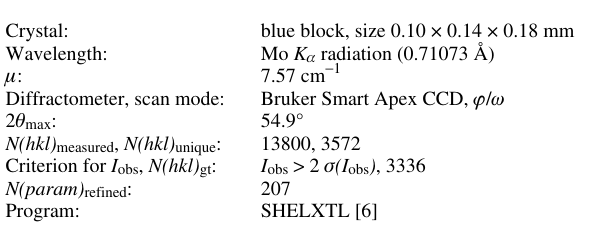
Table 1. Data collection and handling.